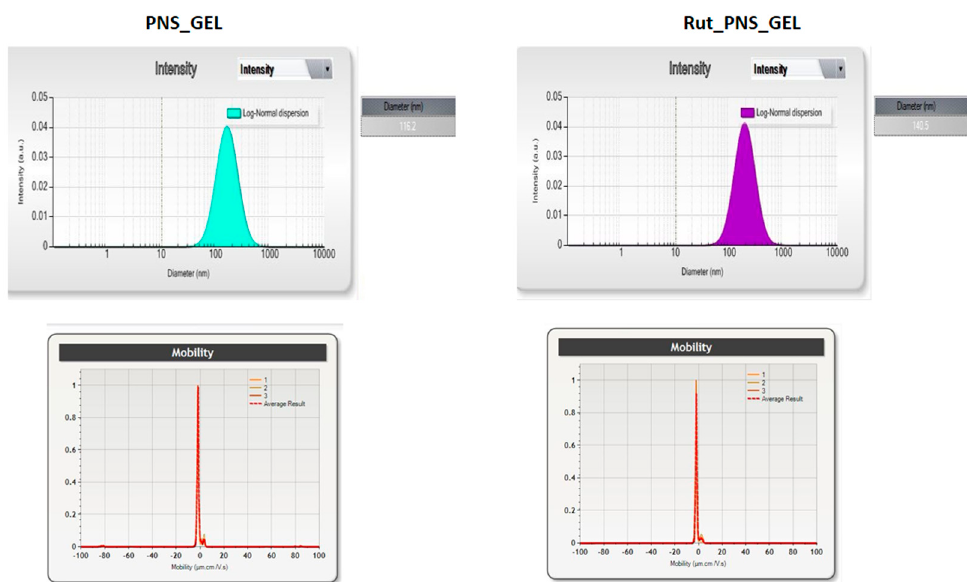
Figure 2. ( top ) Dynamic light scattering data for proniosomal control gel (PNS_GEL) and for proniosomal rutin-loaded gel (Rut_PNS_GEL); ( down ) mean sizes and distribution values for proniosomal control gel (PNS_GEL) and for proniosomal rutin-loaded gel (Rut_PNS_GEL).